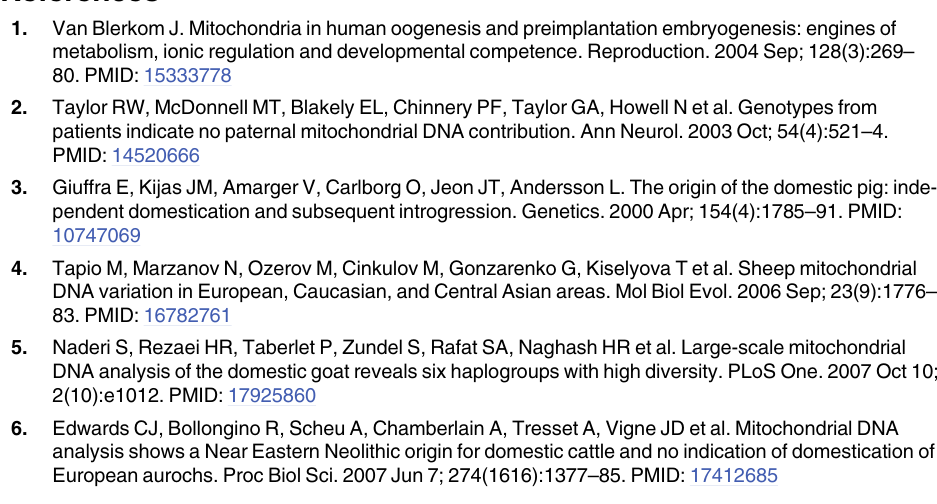
S1 Table. Influence of different factors on gestation length in Warmblood mares. Fixed effects model A — raw means. S2 Table. Influence of different factors on foal sex ratio in Warmblood mares. Fixed effects model B — raw